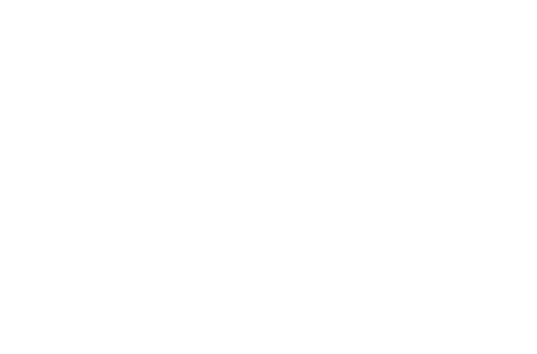
Figure 8. Diagrammatic sketch of a header triangle. 1. Reel; 2. Screw conveyor; 3. Header triangle; 4. Cutterbar.